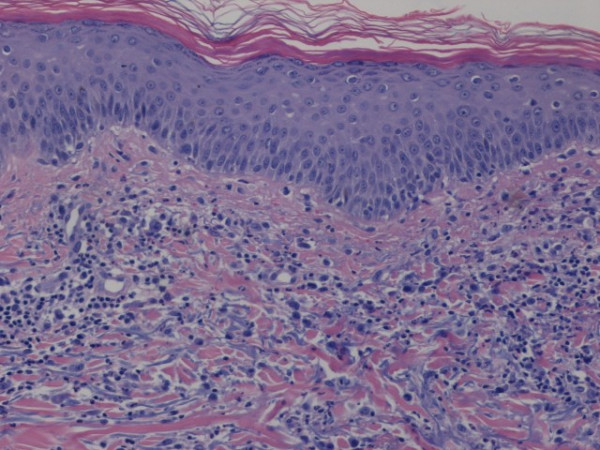
H&E stained sections of lymph node (fig.1) and skin (fig.2) excision in which the diagnostic Reed-Sternberg cell support the diagnosis of Hodgkin disease.